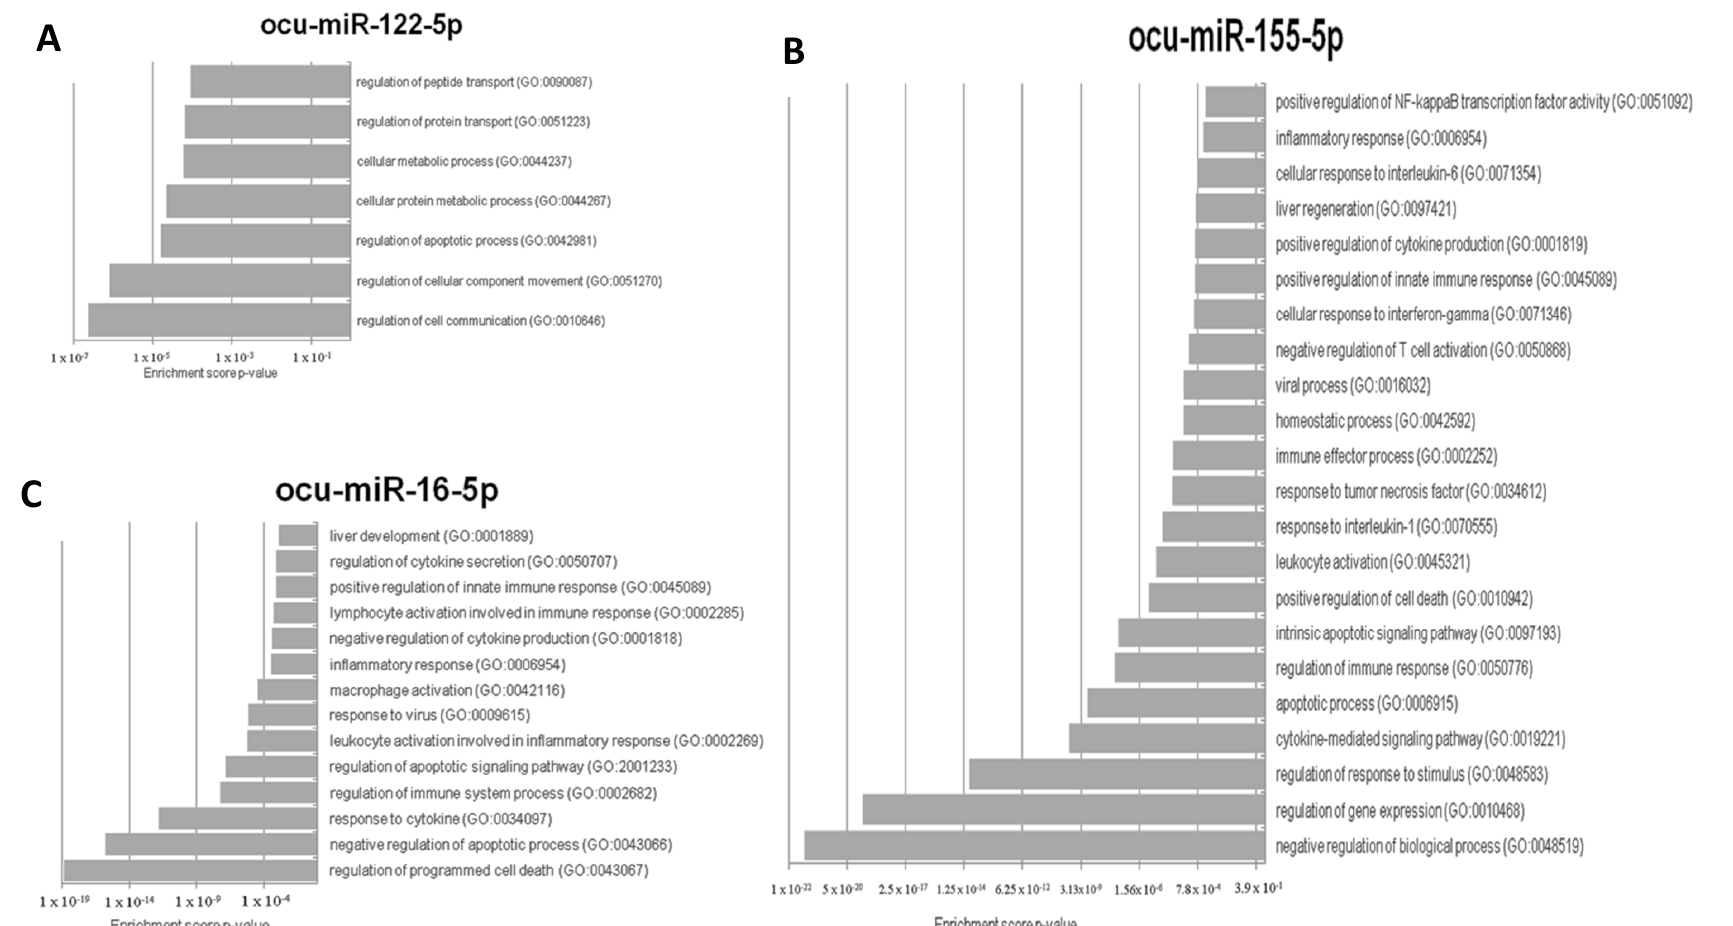
Figure 4. The most relevant rabbit hemorrhagic disease (RHD) pathogenesis and acute liver failure (ALF) gene onthology (GO) processes that can be regulated by ( A ) ocu-miR-122-5p, ( B ) ocu-miR-155-5p, and ( C )